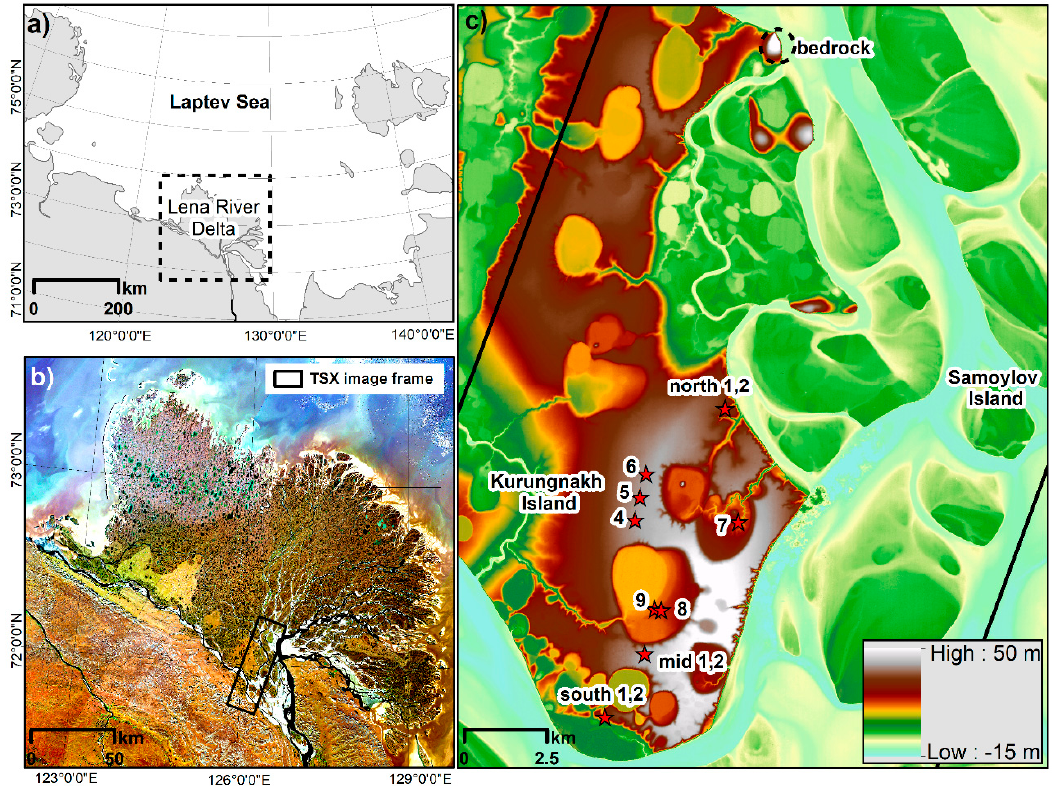
Figure 1. Study area: ( a ) Laptev Sea region and the Lena River Delta; the black dashed square delineates the area shown in ( b ); ( b ) Lena River Delta on a Sentinel-2 image mosaic (RGB 4-3-2) with the TSX image frame delineated in black; ( c ) ArcticDEM with locations of in situ measurements on Kurungnakh-Sise Island depicted by red stars. Bedrock used as a reference stable point for the phase unwrapping is indicated by a dashed circle.